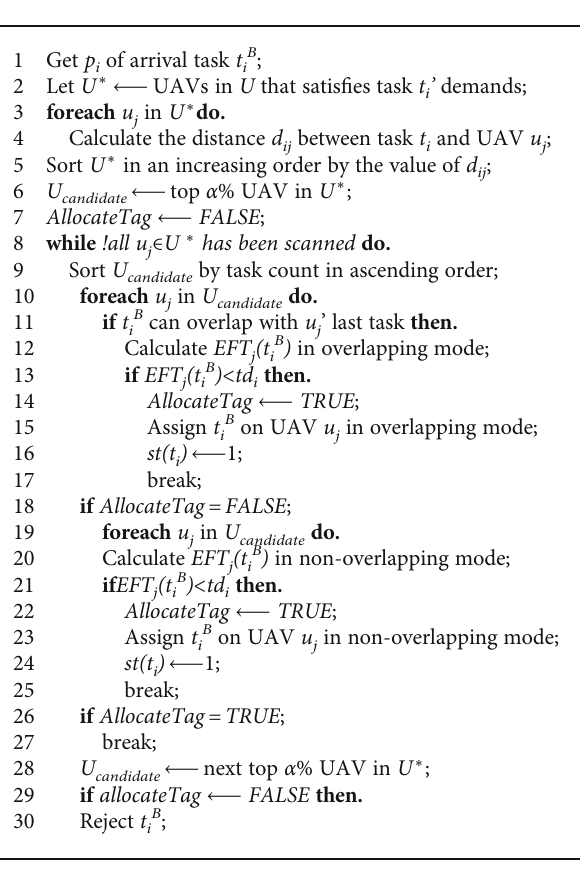
Algorithm 2: Backup Copies Assigning in